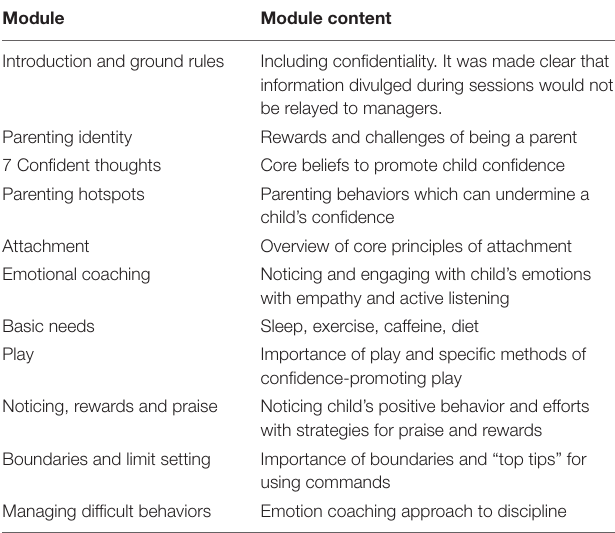
TABLE 2 | Overview of the course content as delivered to participants. The bold line indicates the break point between sessions one, two and three. Module Module